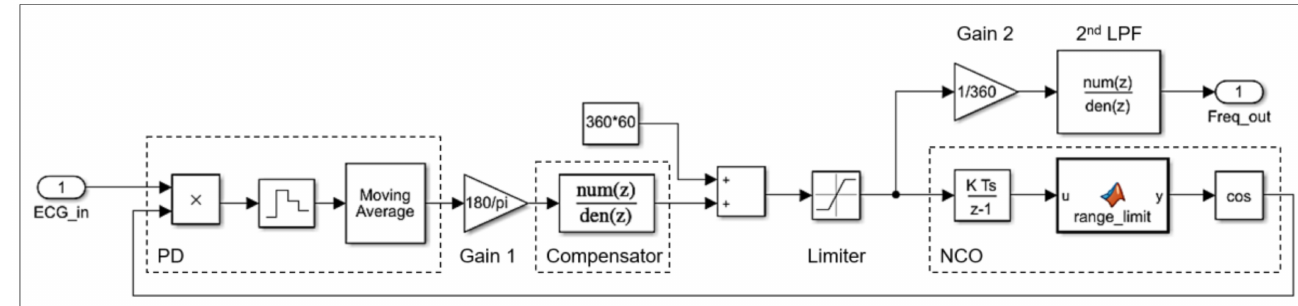
Figure 10. Block diagram of MA-PLL